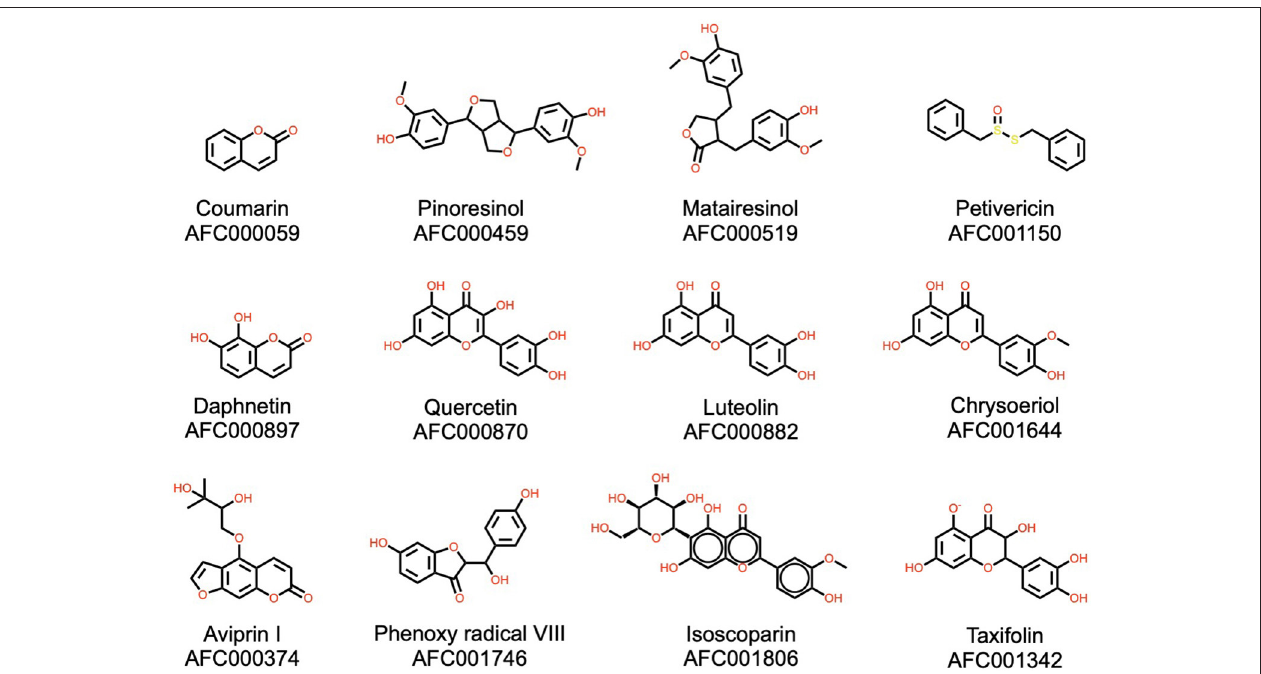
FIGURE 6 | A subset of alkaloids documented in watermelon. Please see Materials and Methods (section AFC Identifiers) for the definition of the AFC identifiers.